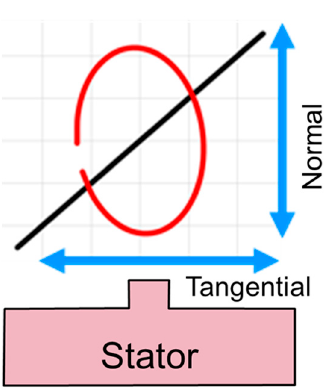
Figure 5. In a resonance-drive type piezoelectric motor, there are elliptical or oblique motions at the stator-rotor (/slider) contact points.